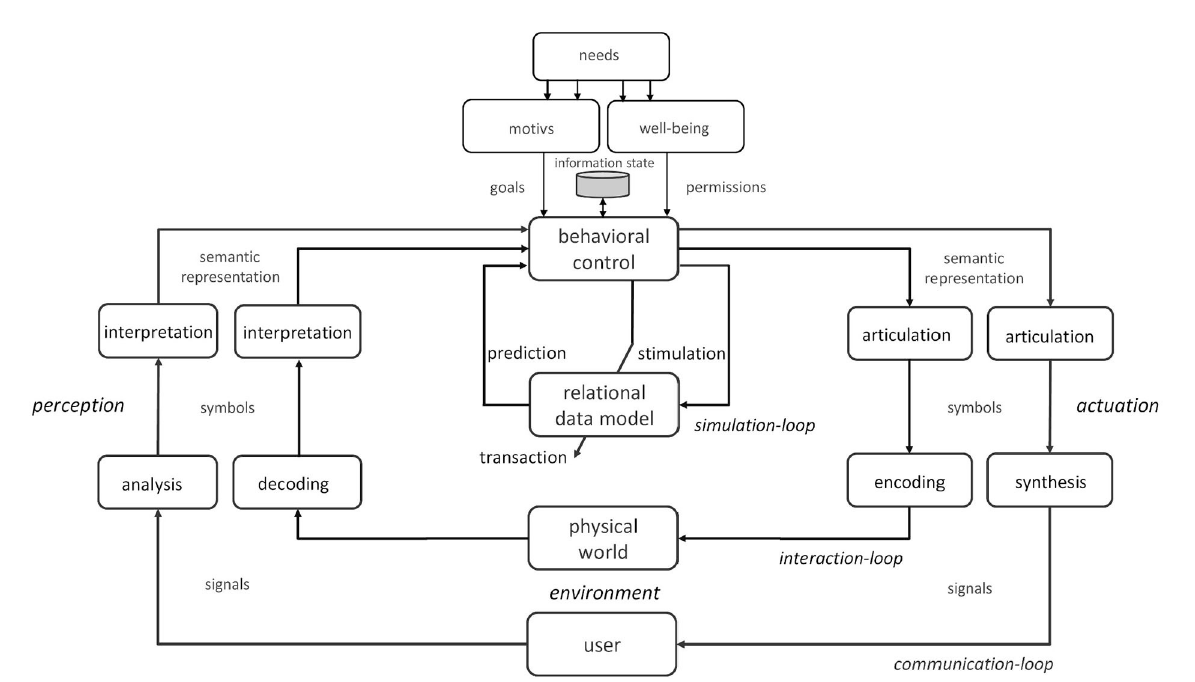
FIGURE2 Double cognitive loop using an embedded relational data model. The inner cognitive loop corresponds to the interaction between the agent and the environment (non-verbal information exchange). The outer cognitive loop is used for the communication between a speech-enabled agent and any other cognitive agent or natural language user (verbal information exchange). The flow of information between the behavioral control and the relational data model is embedded in a simulation loop and enables the simulation of actions as well as the prediction of effects. Since the simulation loop is not linked to the environment through perception and action, this loop is not referred to as a PAC. The exchange of information between two systems with different cognitive abilities (e.g., between humans and cognitive agents) is denoted as Inter-Cognitive Communication